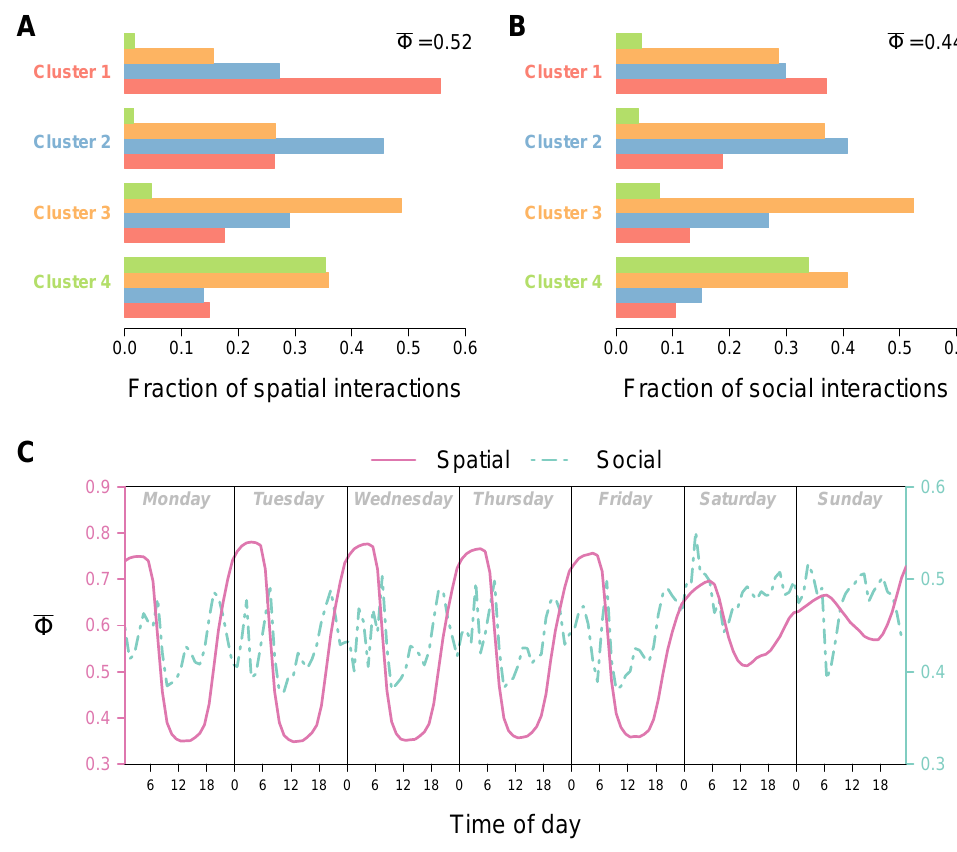
Figure 3. Socio-spatial interactions analysis. ( A , B ) The fraction of spatial ( A ) and social ( B ) interaction within and between clusters. The values of ¯ Φ obtained with both matrices are displayed. ( C ) Temporal evolution of ¯ Φ across week hours for the spatial interactions (in pink) and social interactions (in